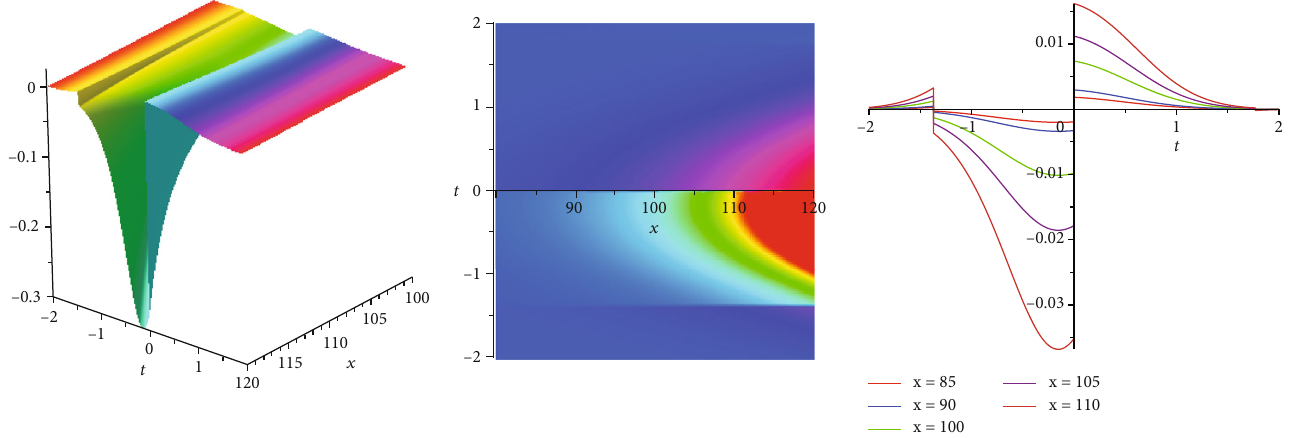
Figure 7: Plot of periodic wave solution (49) ð Σ